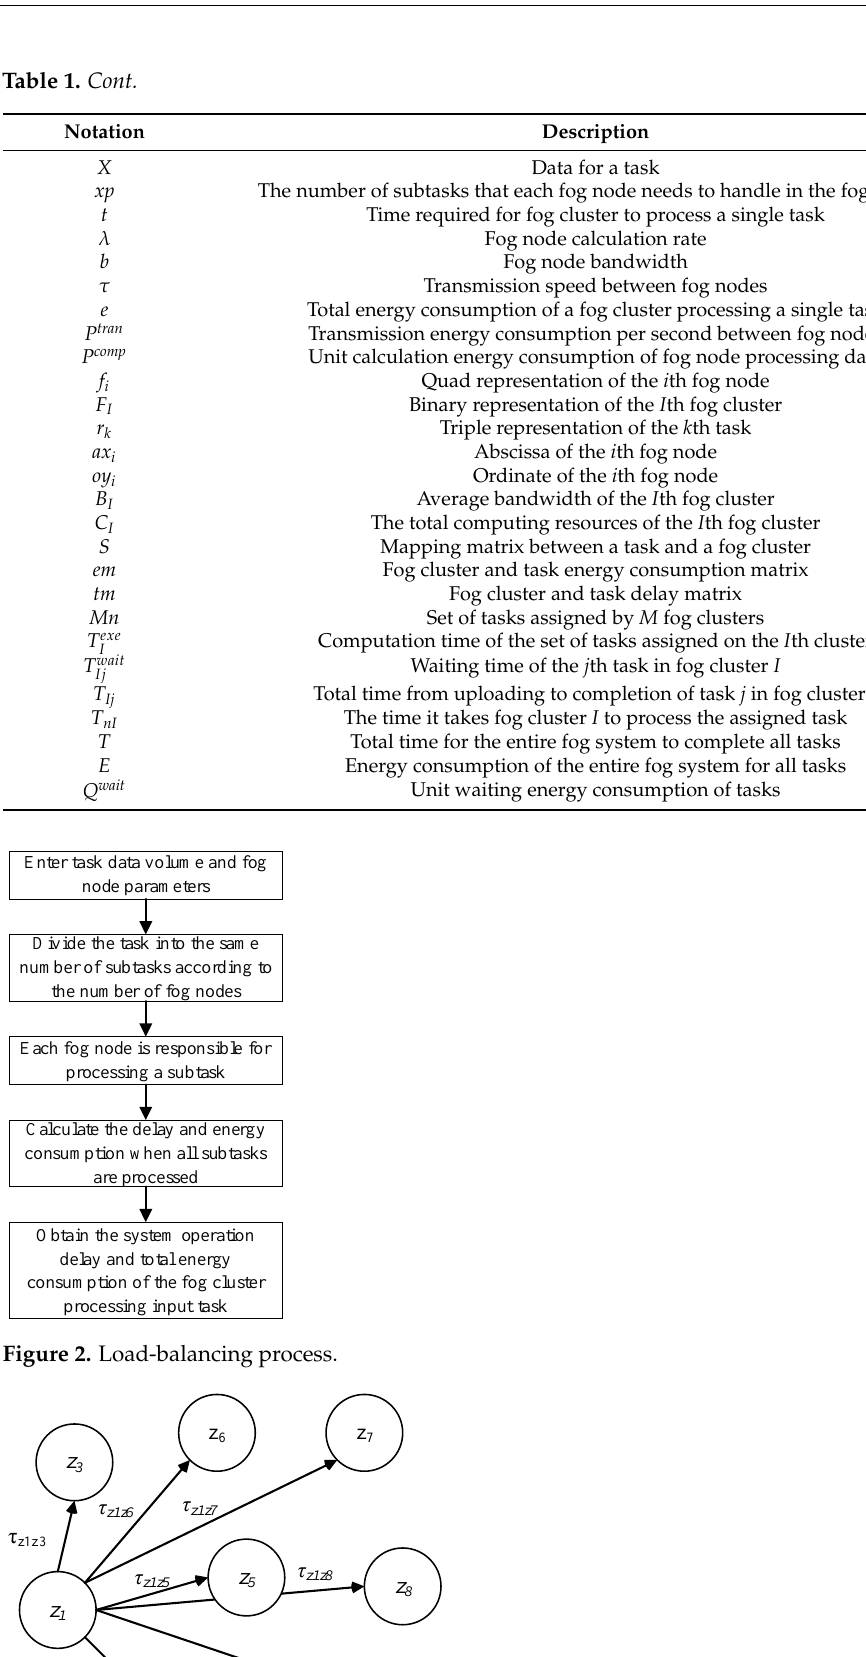
Figure 3. Resource allocation communication graph between nodes. Thus, in the fog cluster, the total processing time t of the input task in the fog layer consists of two parts: the computation delay and the communication transmission delay. This can be expressed as Equation (1). ( )